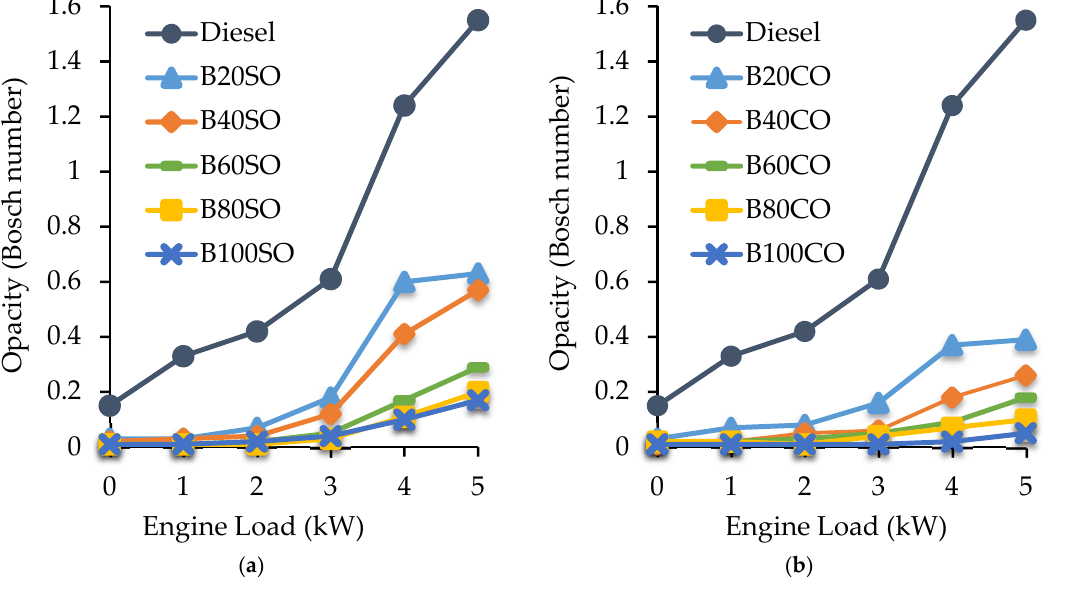
Figure 5. Soot emissions (Bosch number) generated at different engine operating powers (from 0 to 5 kW) with the triple blends: diesel/ABE/sunflower oil ( a ) and diesel/ABE/castor oil ( b ).